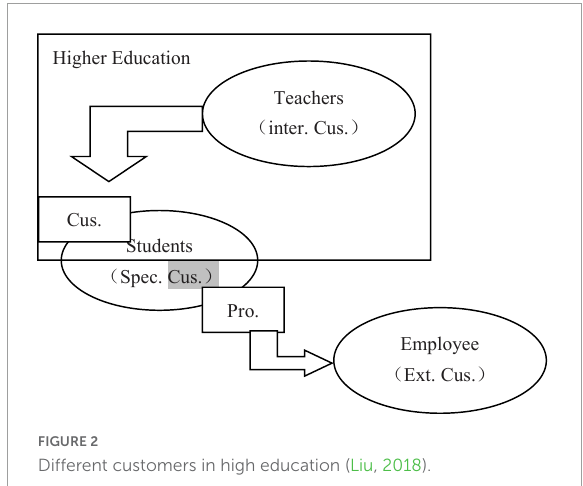
FIGURE2 Different customers in high education (Liu,